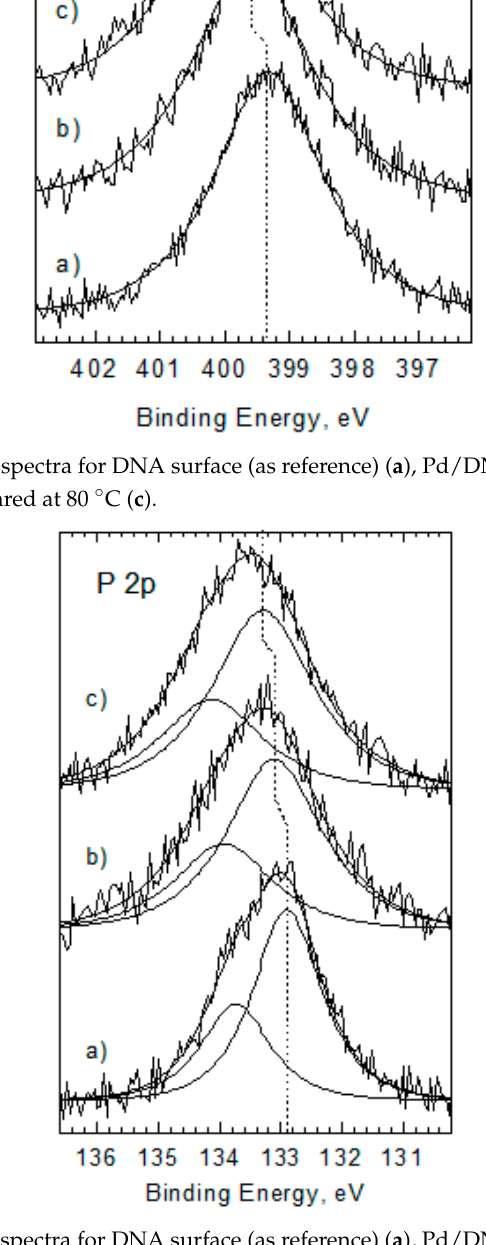
Figure 3. P 2p core level spectra for DNA surface (as reference) ( a ), Pd/DNA (C1) prepared at RT ( b ), and Pd/DNA (C2) prepared at 80 °C ( c ).